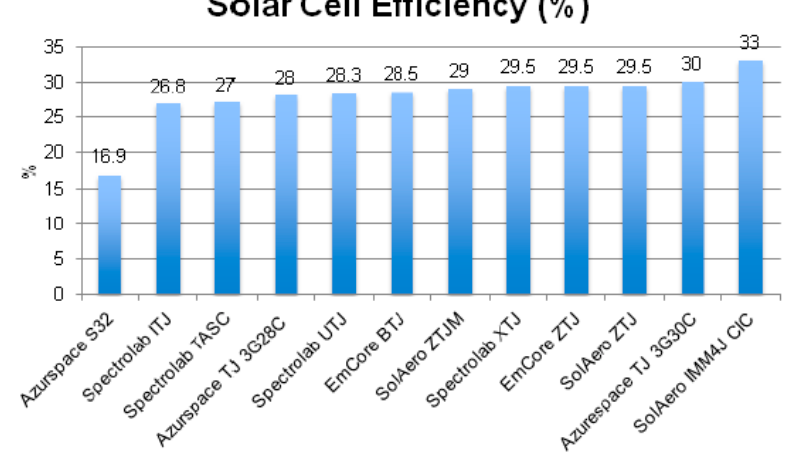
Figure 7. Typical Solar Cell Efficiency [23].